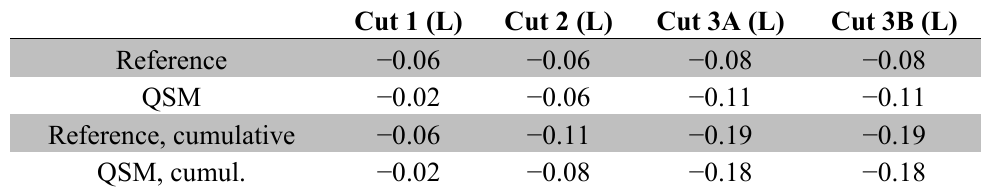
Table 3. Change of aspen branch volume (in (litres)) after each cut. Cuts 3A and 3B represent two independent scans of the tree after the third cut (the reference being the same).